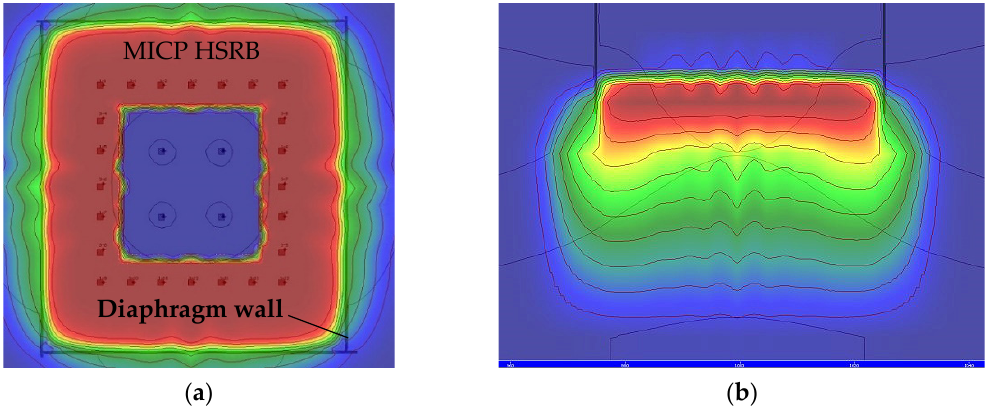
Figure 20. Migration of S. pasteurii in condition 7: ( a ) Horizontal; ( b ) Vertical.